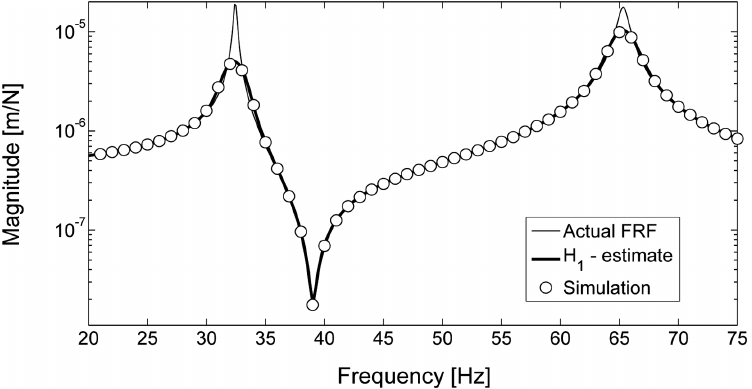
Fig. 2. A simulation on a mass-spring-damper system is performed and the result with Welch’s method and the H 1 -formulation is compared with the system’s true FRF. After averaging, a relatively large bias error is obtained at the resonances. Finally, the simulation results are veri fi ed by comparing with the theoretical biased FRF (-) as given in Eq.